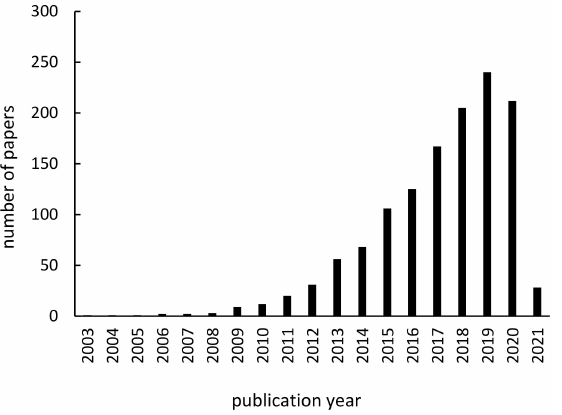
Figure 1. Number of papers published annually on plasmonic photocatalysis searched in Web